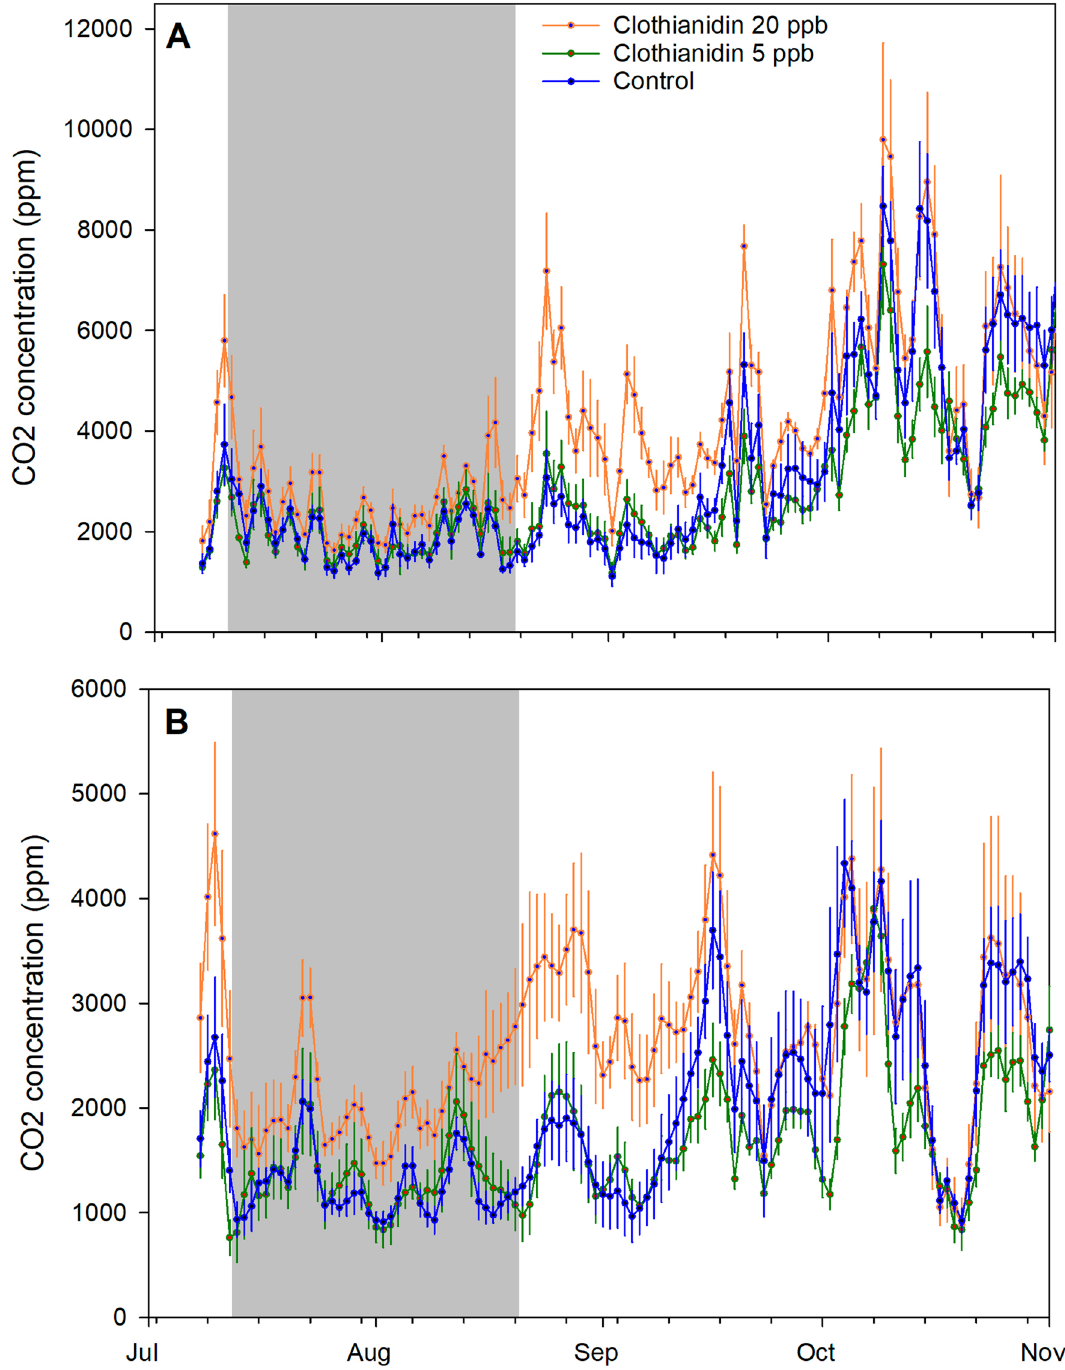
Figure 9. Running average CO 2 concentrations, and daily amplitudes of sine curves fit to within-day CO 2 concentration changes per day (see text for details), for each of 3 treatment groups: Clothianidin 20-ppb (orange), clothianidin 5-ppb (green), and control (blue) for the AZ 2018 experiment. The gray area shows the treatment period. ( A ) 24 h running average; ( B ) daily